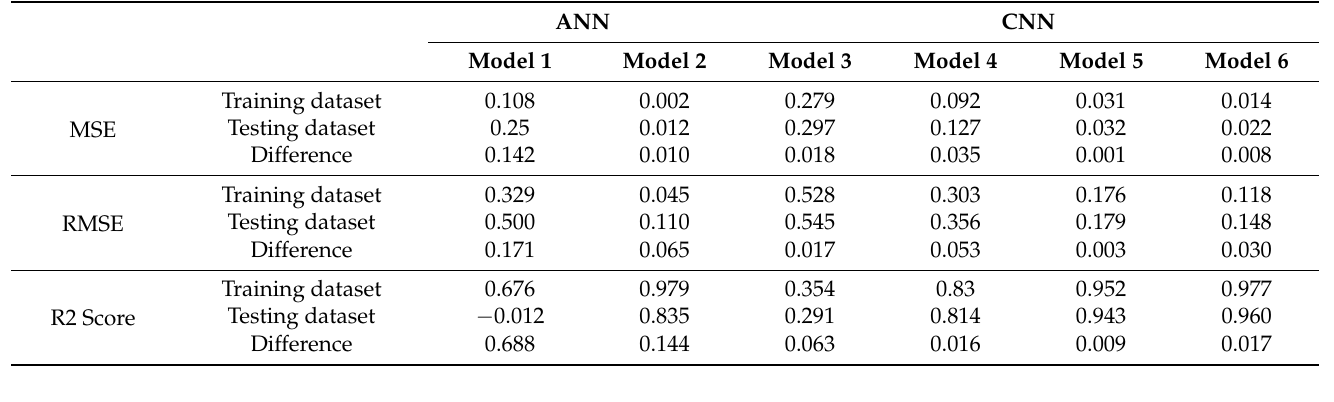
Table 9. Performance of Group B models at 300 epochs.